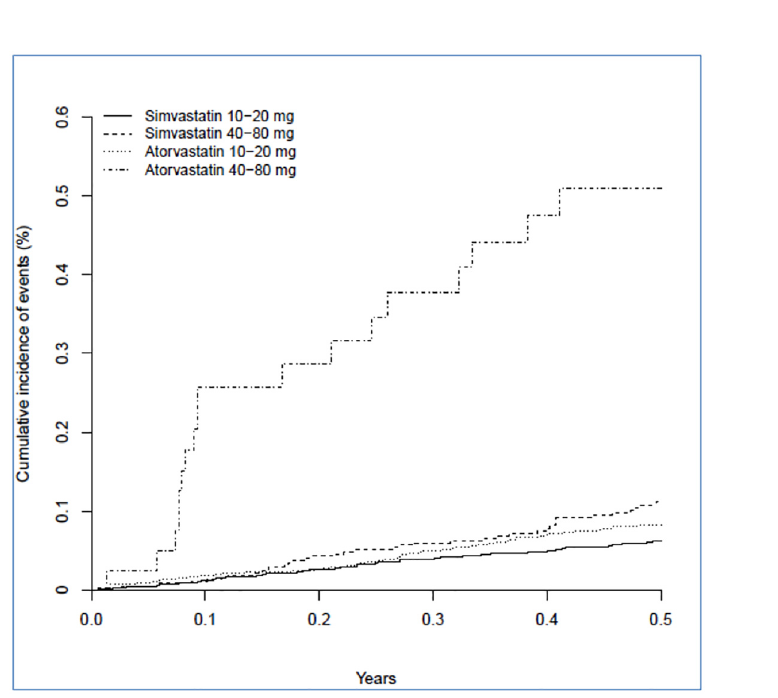
Fig 2. Cumulative incidence of moderate-severe hepatotoxicity for atorvastatin and simvastatin [high and low dose groups] over 6 months after index dose.